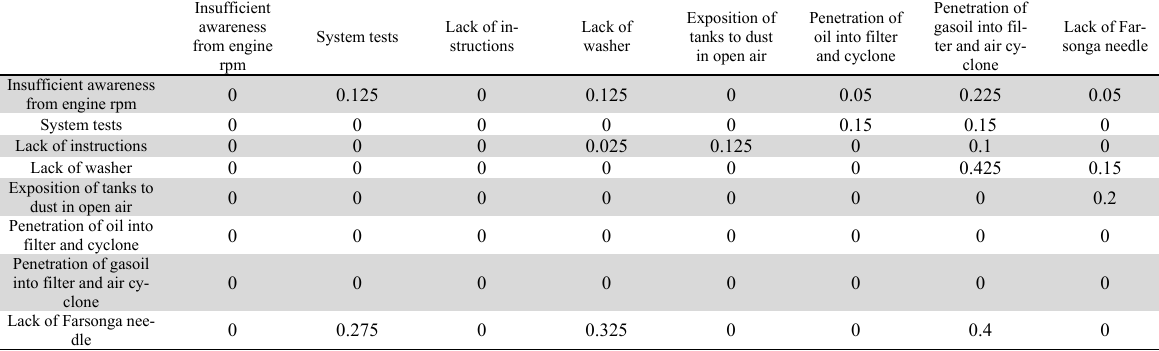
Fig. 2. Network of cause and effect analysis on "mixing oil & fuel" in UTD-20 engine Normal